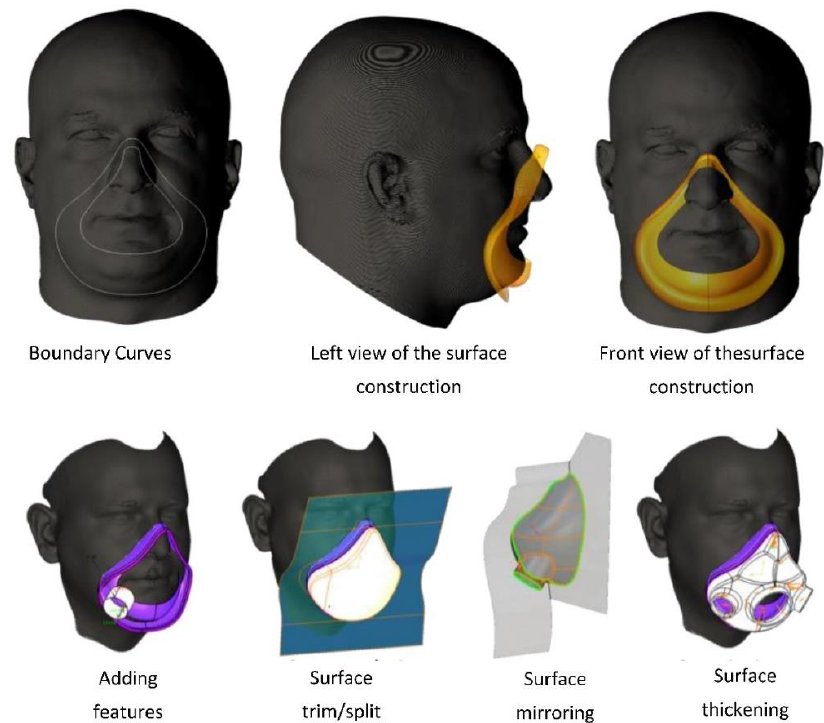
Figure 5. Construction of boundary curves and surfaces for the face flange and the main body.